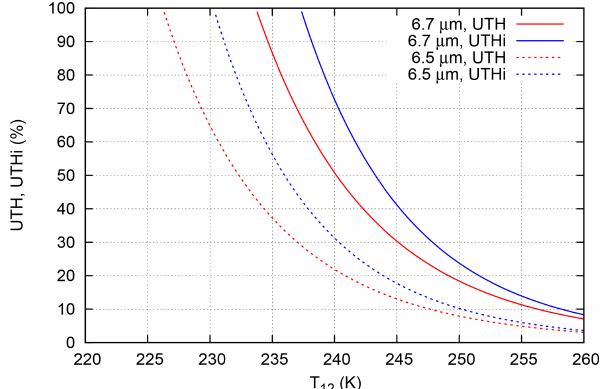
Figure 6. Second-order retrieval functions for all cases of Table